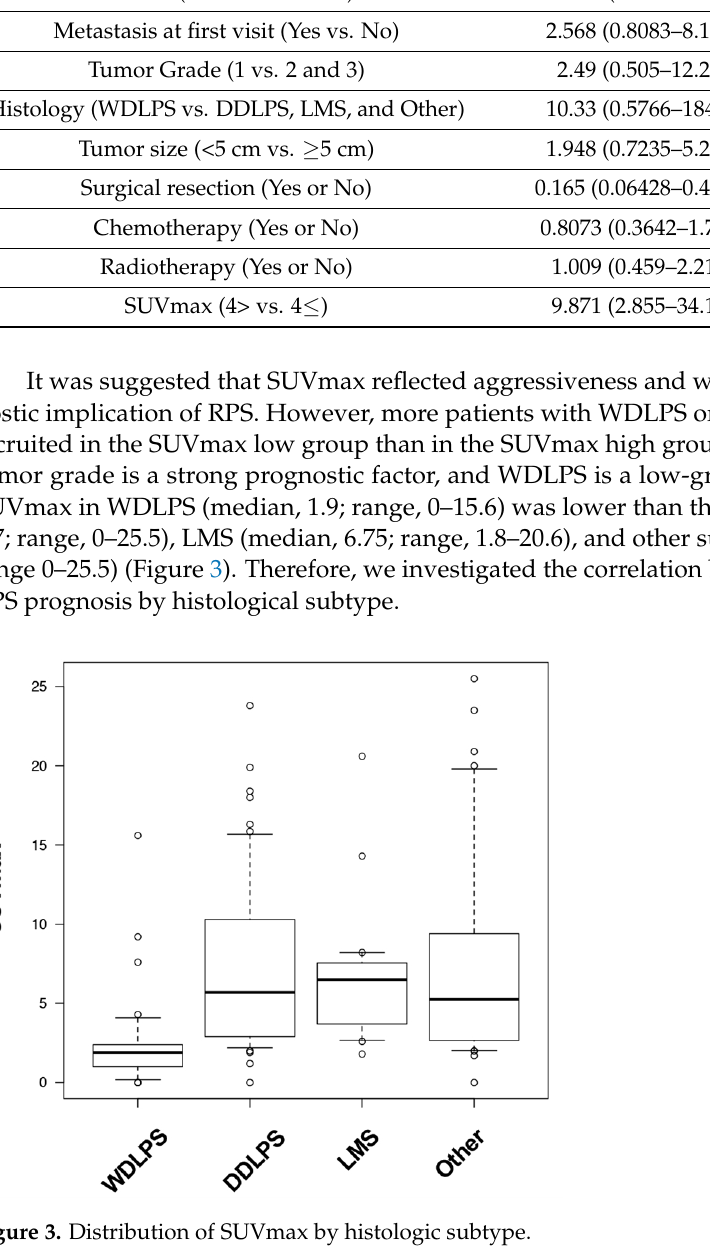
Table 5. Analyses on survival in all DDLPS patients.